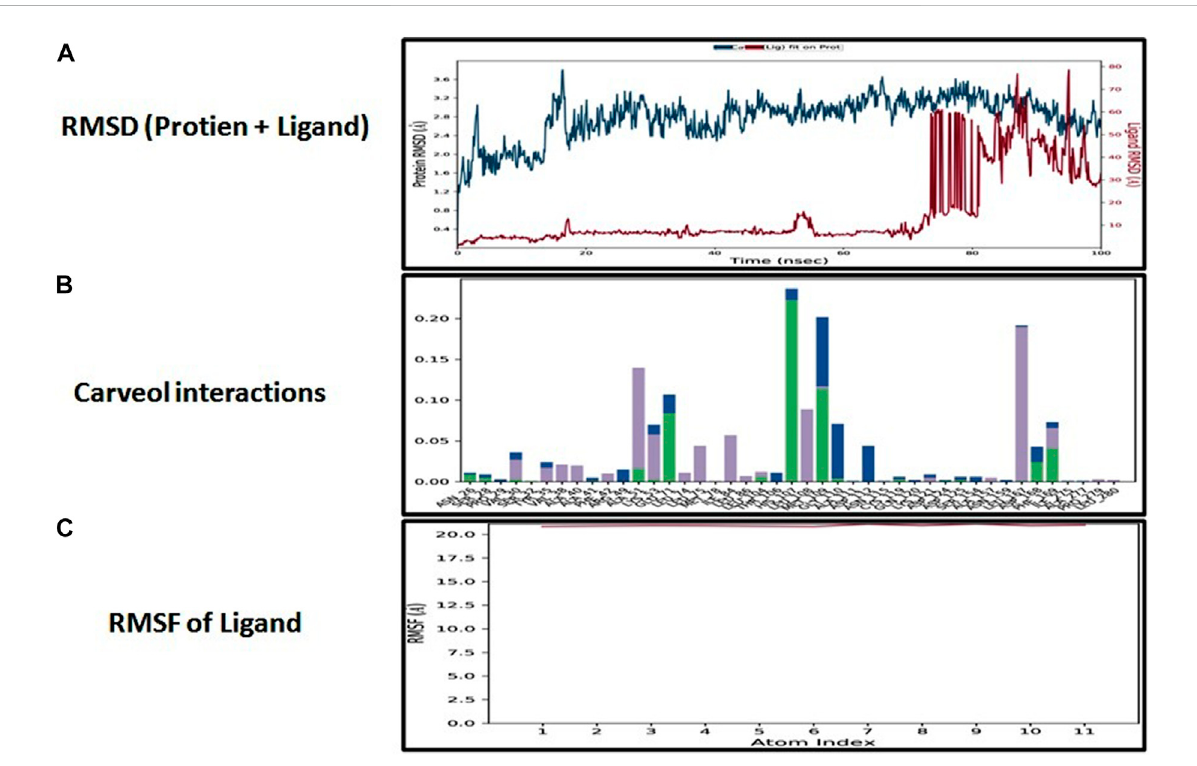
FIGURE 6 Represents root mean square deviation (RMSD) of mitogen-activated protein kinase (MAPK, PDB I.D: 5UOJ) and carveol (A) , interactions (hydrogen bonds, hydrophobic interaction ionic and water bridges) of carveol (B) , and root mean square fl uctuation (RMSF) of carveol (C) , obtained through Desmond software